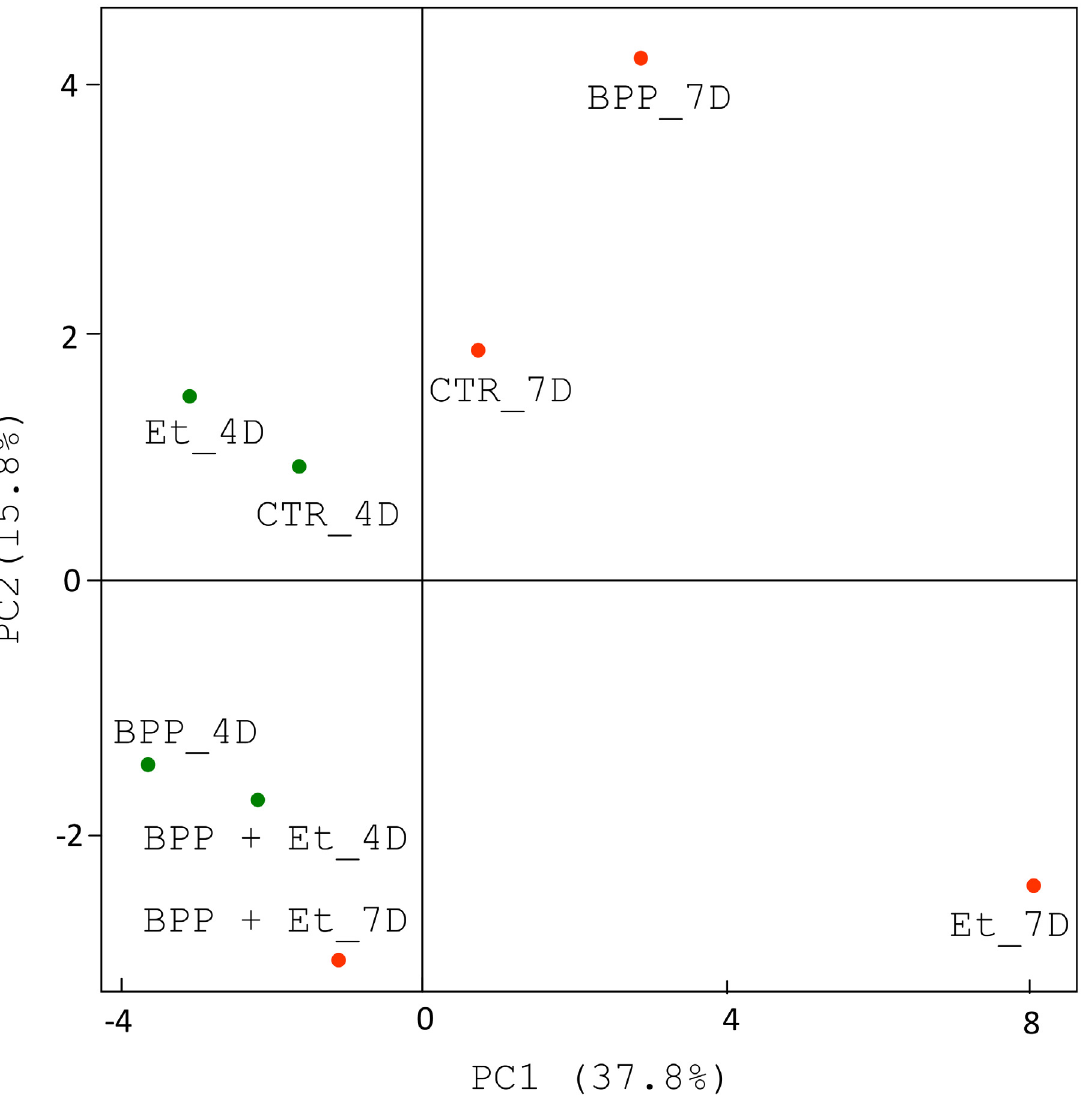
Fig 3. Principal component analysis of the bacterial community compositions at the genus level in the guts of chickens. Principal component analysis was conducted to compare the bacteria genera based on the 16S rRNA sequences in 8 samples as in Fig